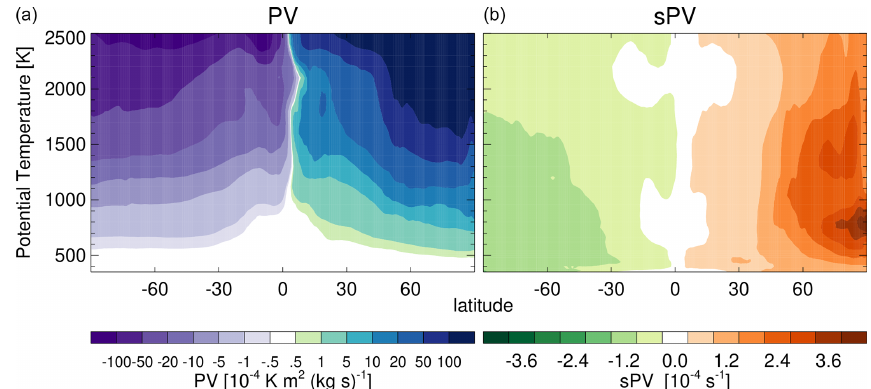
Figure 1. 1 January 2005 PV (a) and sPV (b) . Note that sPV has similar order of magnitude values throughout the stratosphere as opposed to PV (for which the color bar is non-linear).